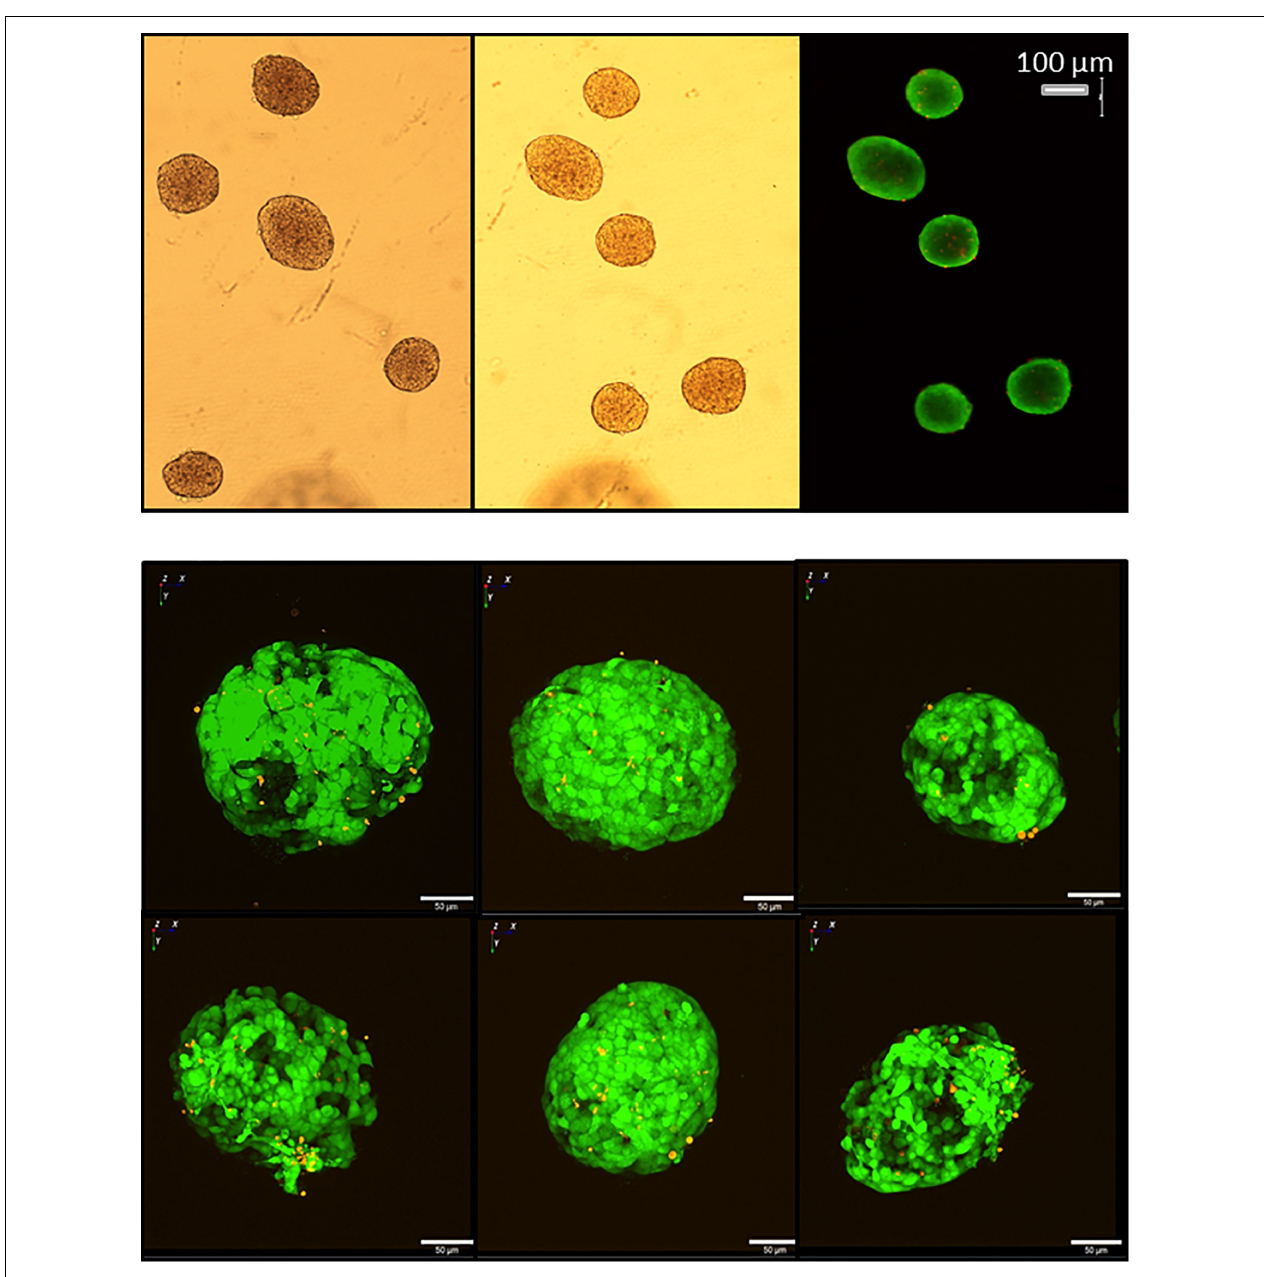
FIGURE 13 | Live/dead assay of islets before and after removal from the microfluidic system. Upper micrographs: islets were inserted in and removed from the parallel perifusion slide and loaded thereafter with calcein (green fluorescence) and ethidium homodimer III (red fluorescence). Transmitted light micrograph before insertion (left) and transmitted light and fluorescence micrographs 5 min after removal from the chip (middle and right). Red nuclei are sparse, the entirety of the islets is labeled by calcein. Lower micrographs: calcein- and ethidium-loaded islets were imaged by spinning disk confocal microscopy before (upper row) and after insertion into the slide and removal (lower row). The number of red fluorescent nuclei indicating cell death did not increase and were only located in the islet periphery. The length of the scale bars is 50 µ